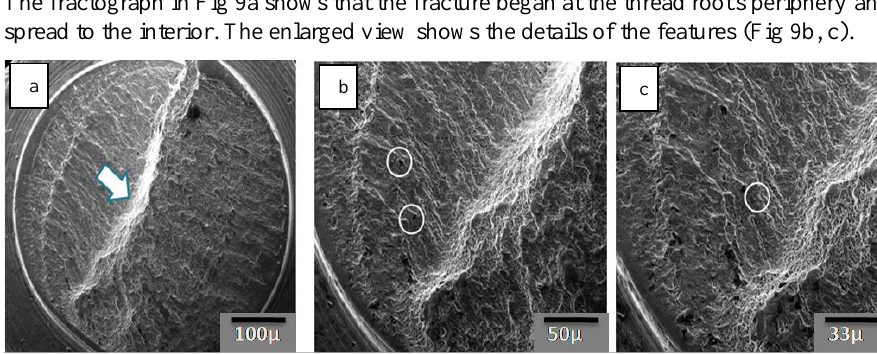
Fig. 9. Scanning electron fractographs of the retrieved implant